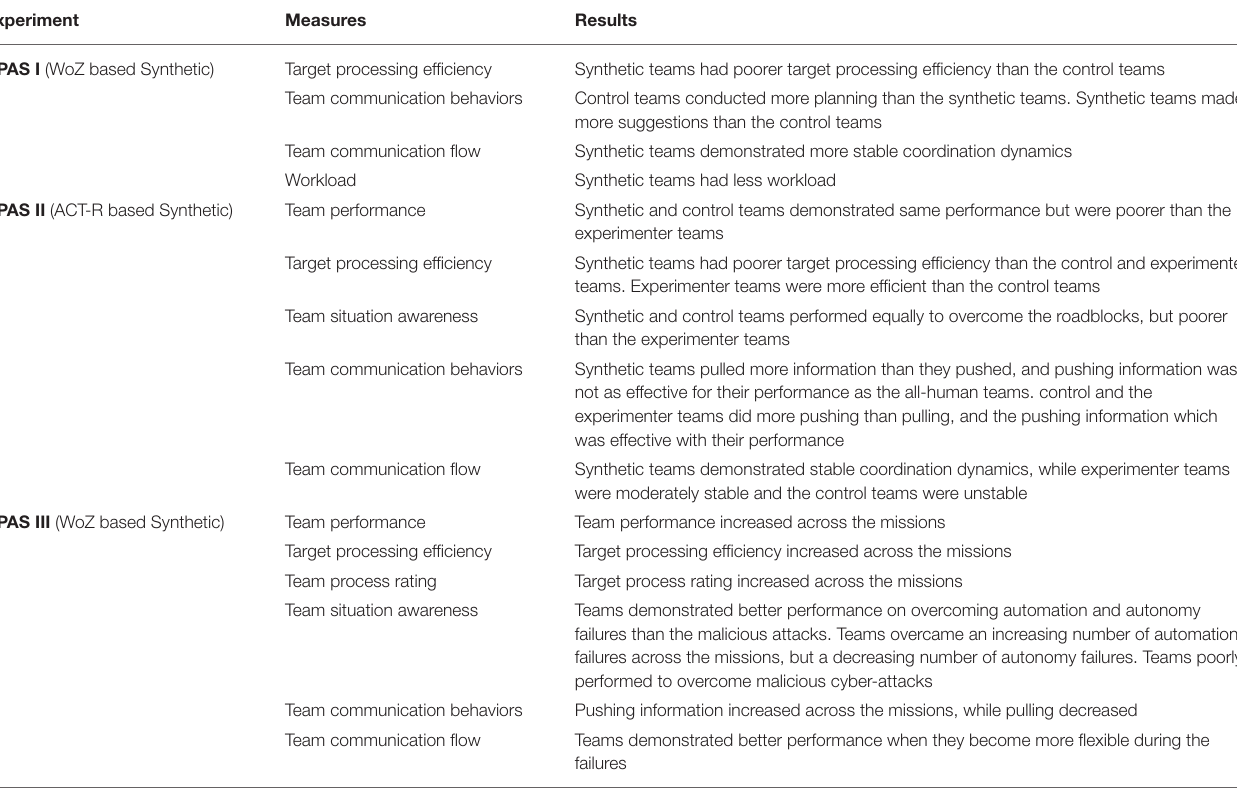
TABLE 3 | Key findings from three RPAS